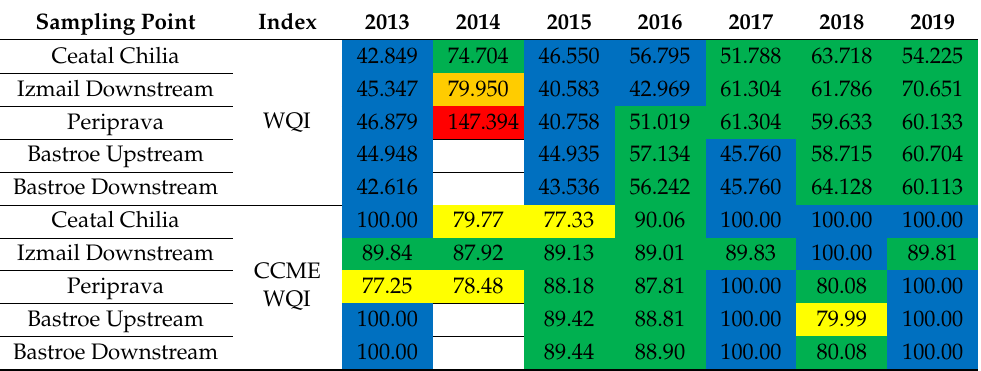
Table 8. Comparison of Danube river Chilia branch water quality classification * according to CCME WQI and WQI.